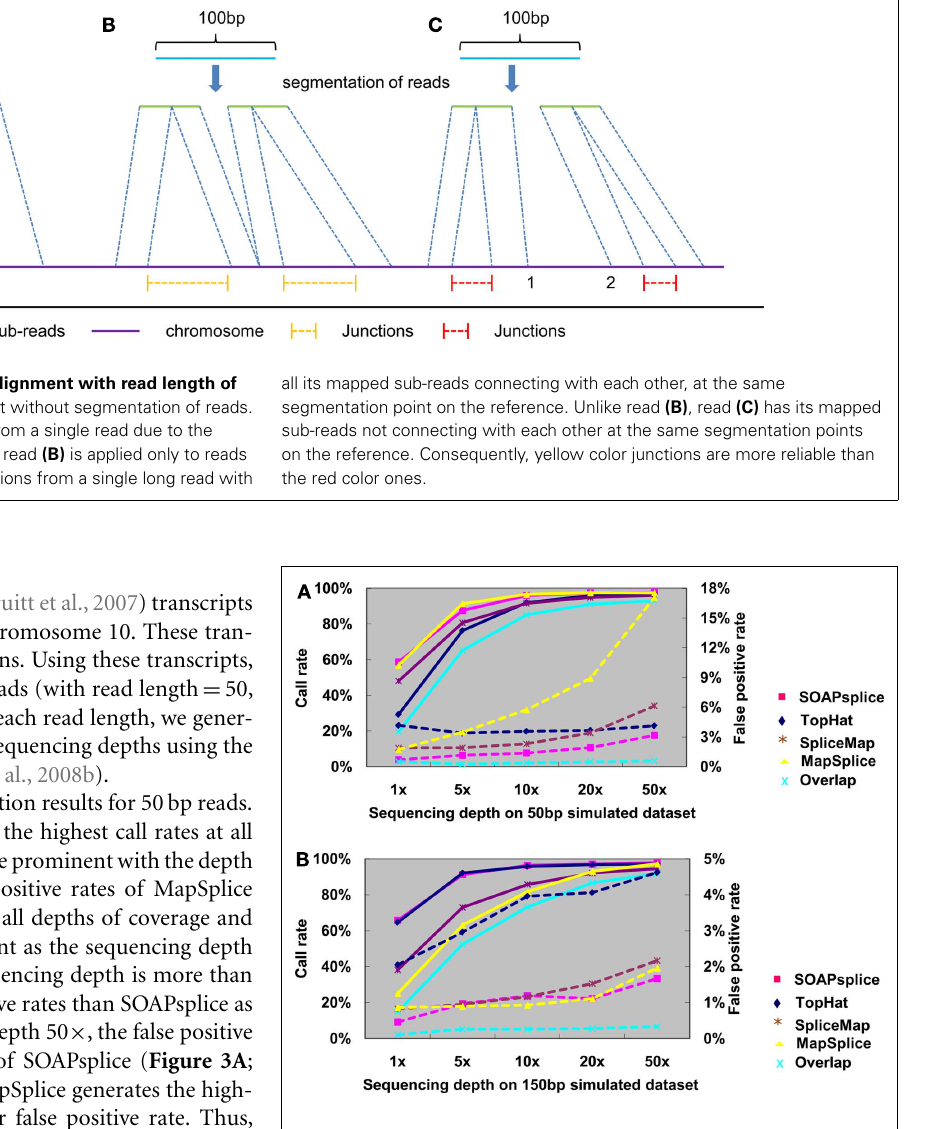
FIGURE 3 | Comparison of four tools for junction predictions on 50 and 150bp simulated reads. For 50bp reads in (A) and 150bp reads in (B) , the points connected by full lines stand for the call rate at certain sequencing depth, and the points connected by dashed lines stand for the false positive rate. Call rate is equal to the number of true positives divided by the total number of junctions. False positive rate is calculated by dividing the number of false positives by the total number of detected junctions. Overlap represents the number of common junctions reported by all four